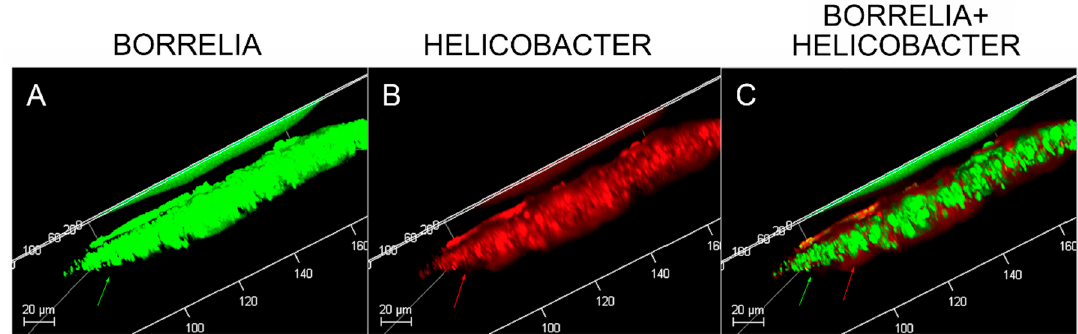
Figure 8. Confocal microscopy of MD skin sections. Confocal microscopy was performed as described in the Methods section. Panel A, staining for Borrelia alone (green). Panel B, staining for Helicobacter alone (red). Panel C, staining for both Borrelia and Helicobacter . Note, Helicobacter localization occurred mainly on the external part and Borrelia localization occurred mainly on the internal part of the section. All images were taken at 200× magnification.